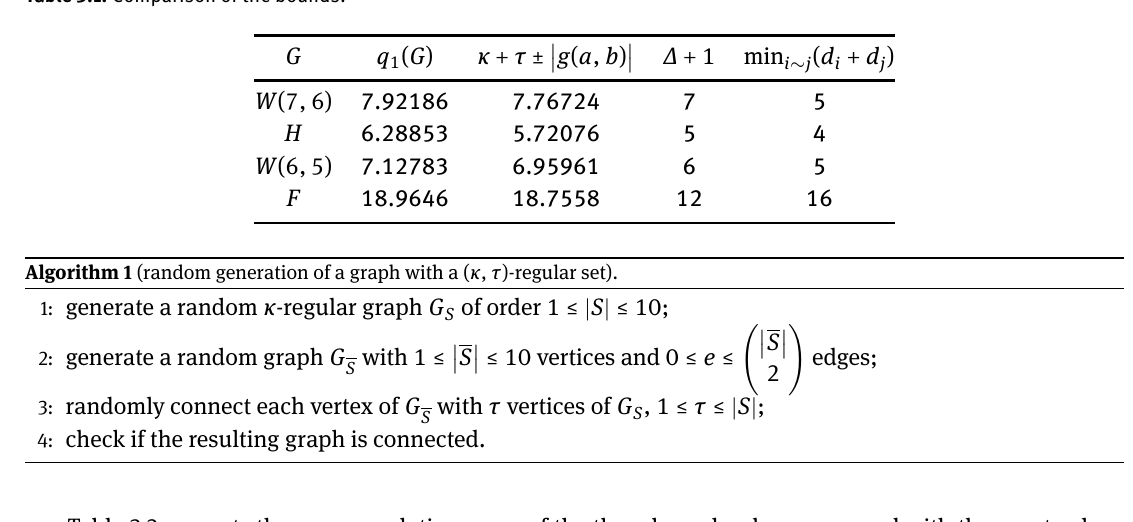
Table 3.1: Comparison of the bounds.